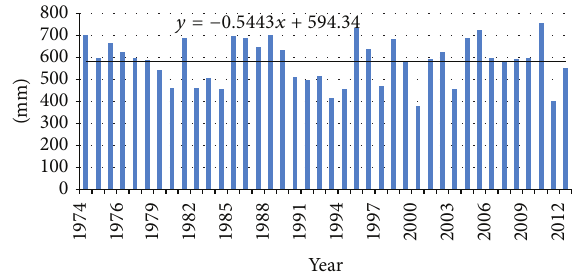
Figure 4: Linear tendency (trend) equation for period from 1974 to 2012 for average rainfall in meteorological station Prokuplje.